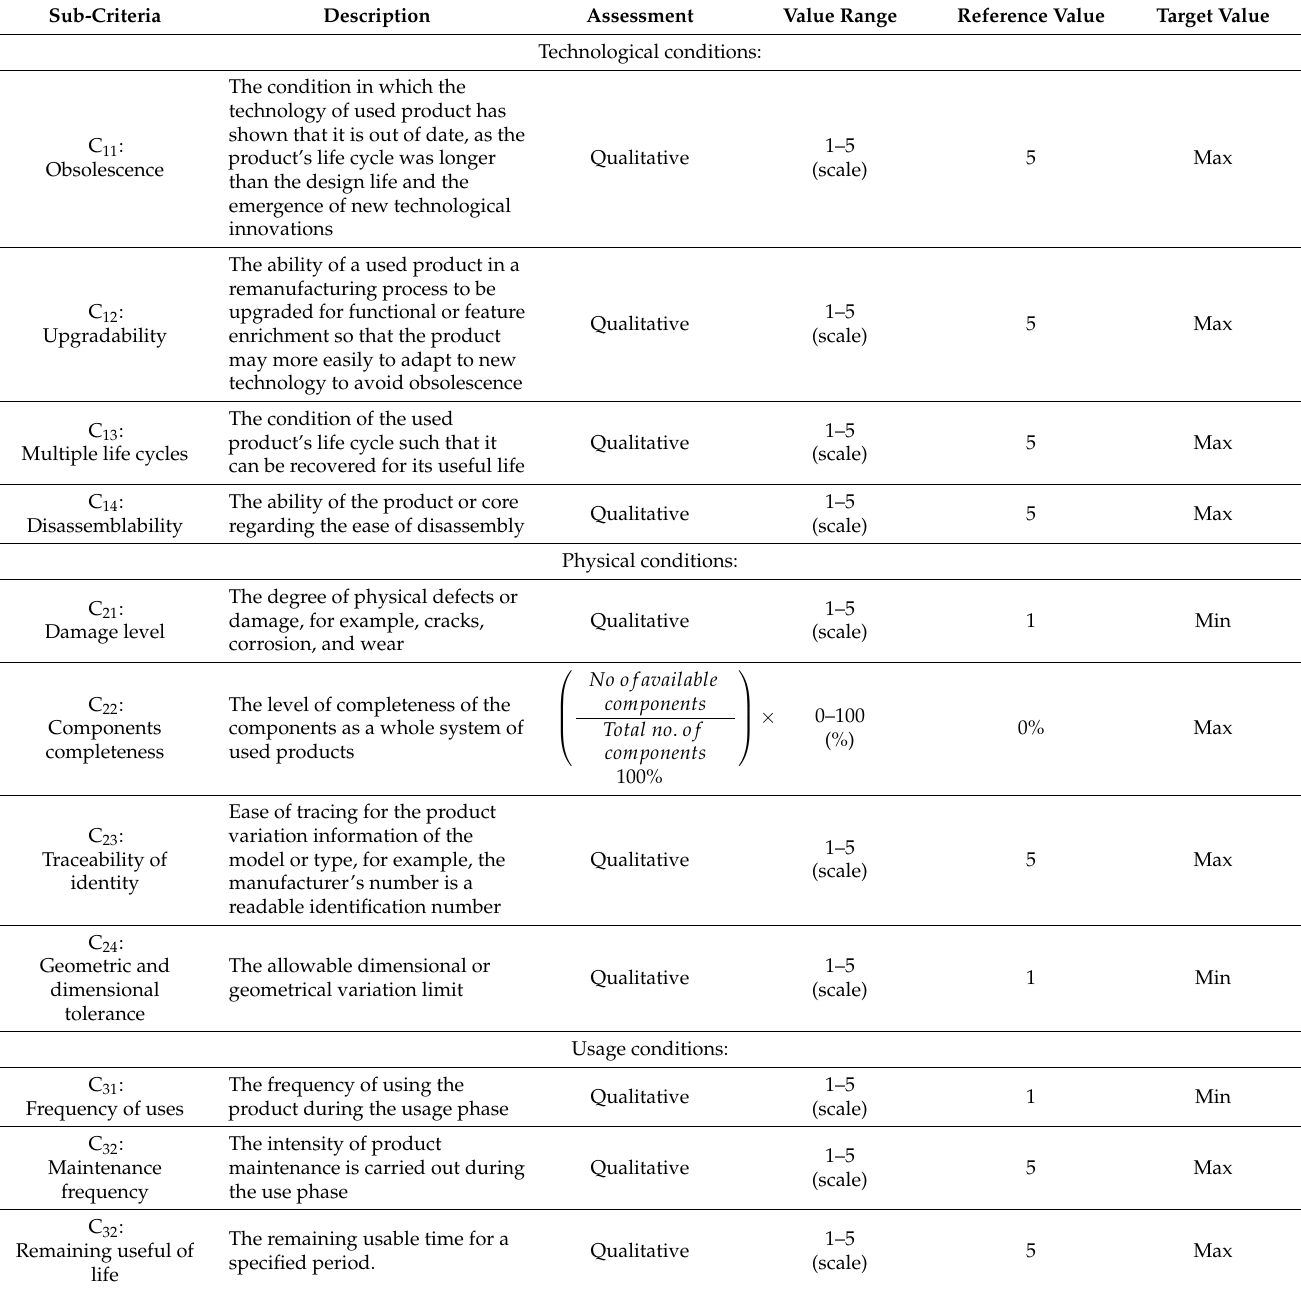
Table A1. List of criteria and sub-criteria considered for assessing the quality levels of incoming cores.